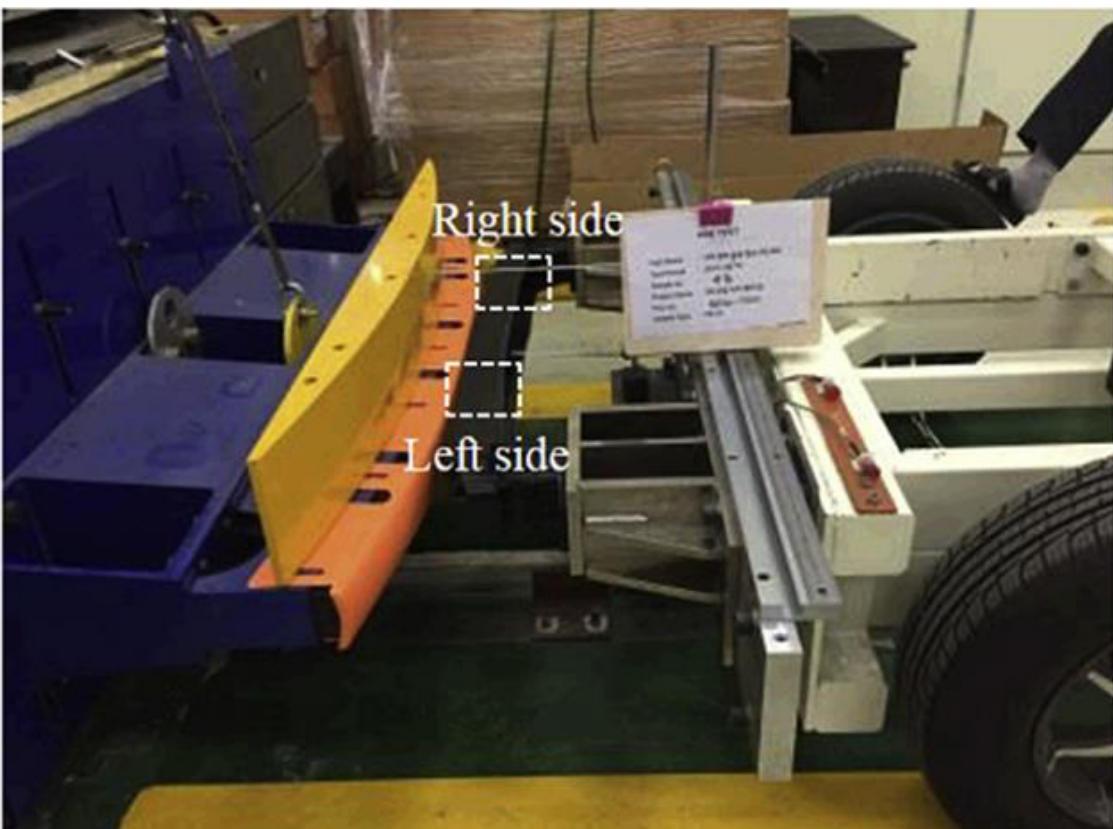
Figure 13. The glass fiber reinforced thermoplastic polypropylene (GFPP) bumper beam impact test [36].